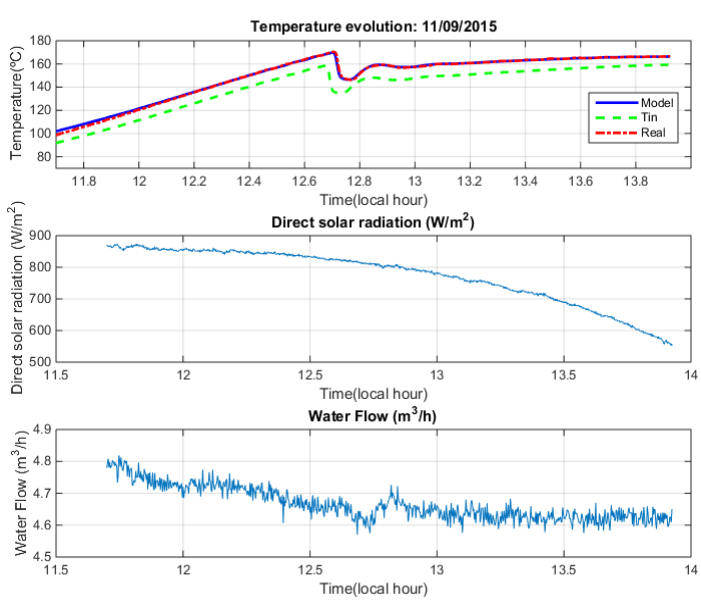
Figure 4. Solar field evolution Model vs Real: 11 September